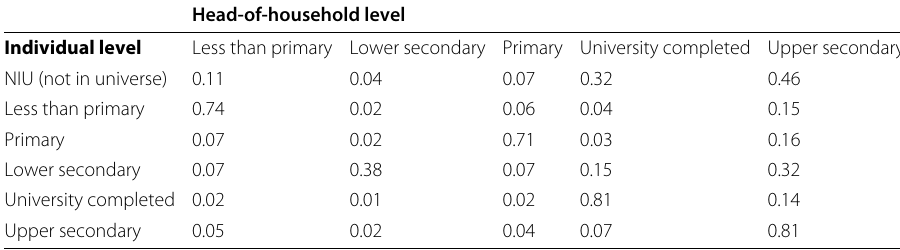
Table 5 Comparison table between individual and head-of-household variable education level Head-of-household level Individual level